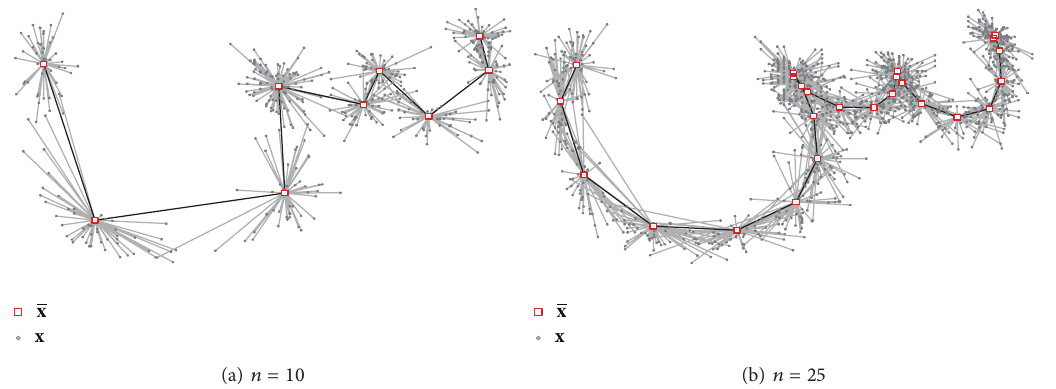
Figure 2: The average x and 𝑟 samples x for the letter Sin in isolated form of writer 1. (a) The number of interpolation steps 𝑛 = 10 is not % sufficient to represent complex characters as Sin ( ), and details will be lost or distorted. (b) With 𝑛 = 25, the approximated samples x are reliable enough to build proper ASMs for all character